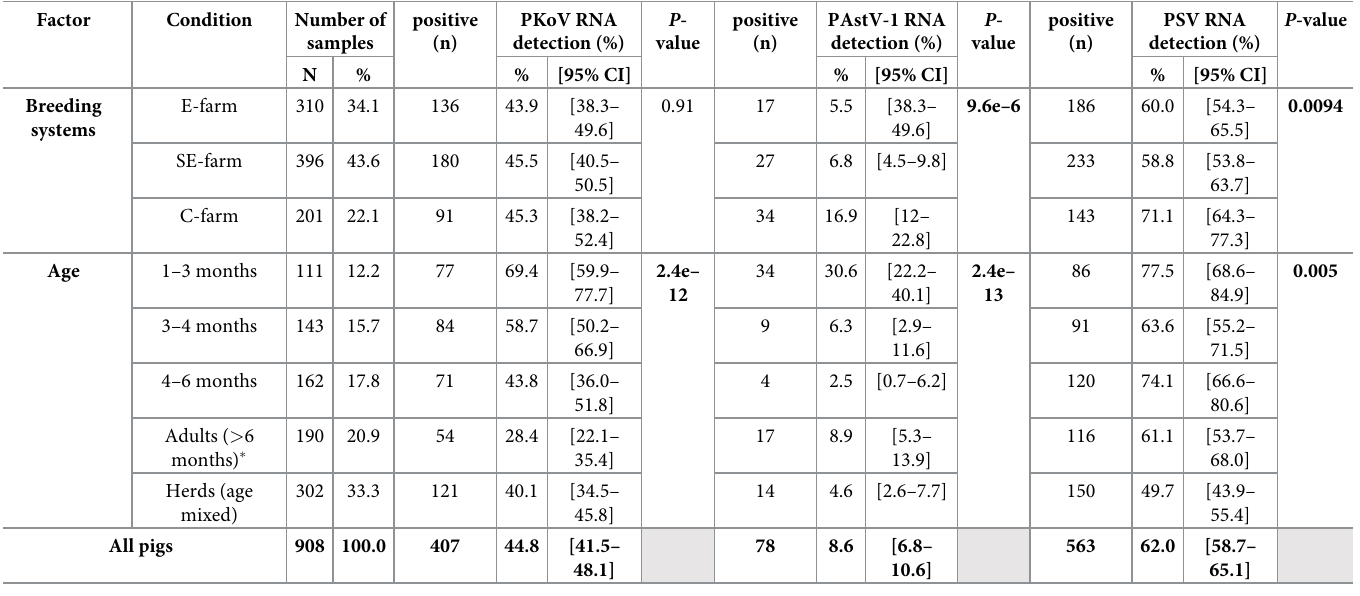
Table 2. Viral RNA in stools of domestic pigs stratified by breeding system and age. Factor Condition Number of